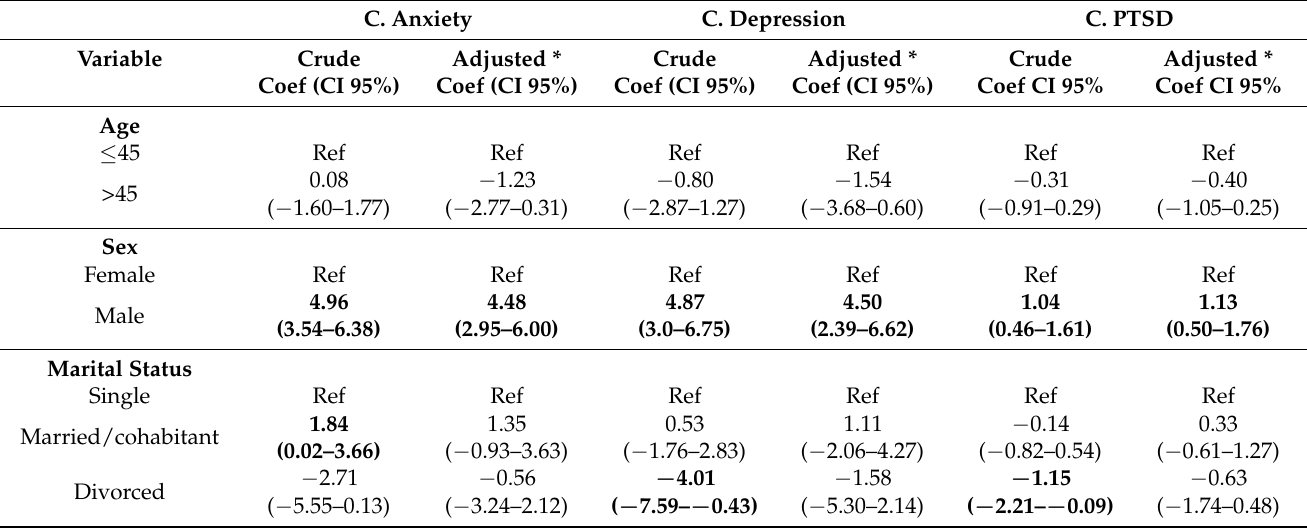
Table 3. Potential associated factors with anxiety, depression, and